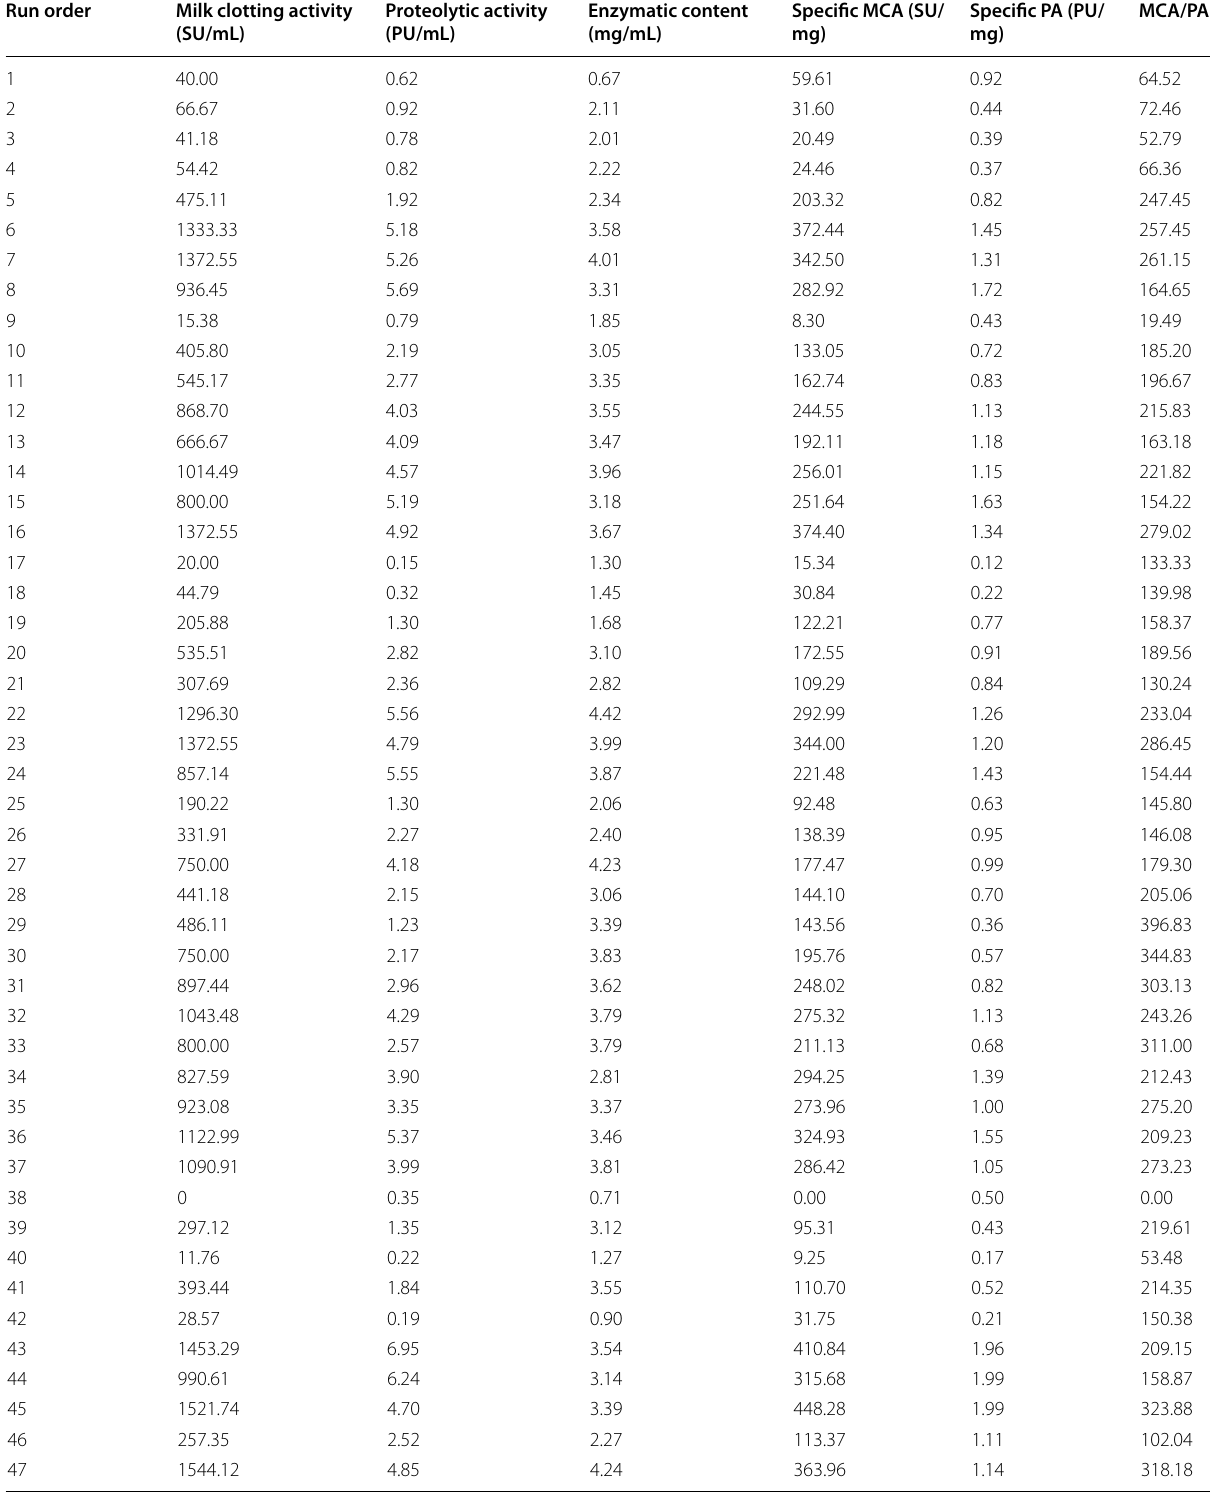
Table 5 Observed values for the response